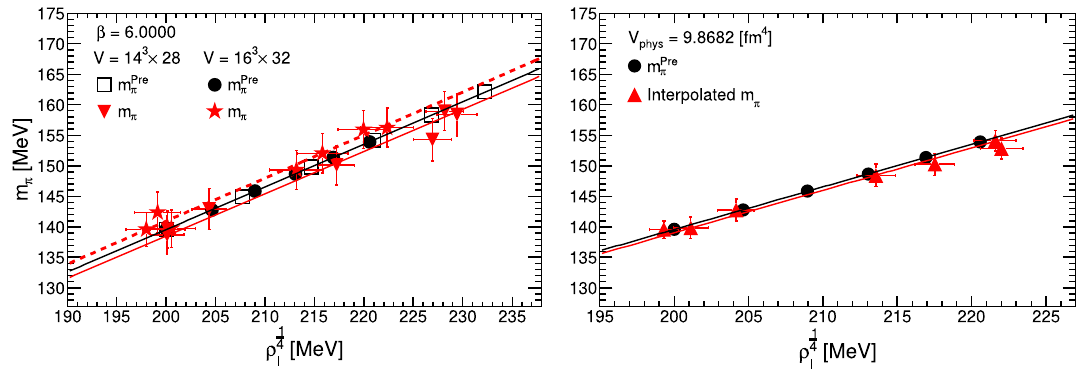
Fig. 17 Comparisons of the pion mass m π of the configurations of β = 6 . 0000, V = 14 3 × 28 and V = 16 3 × 32 (left) and the interpo- lated results at the continuum limit (right) with the predictions m Pre π . In the left figure, the black full line, the red full line, and the red dashed